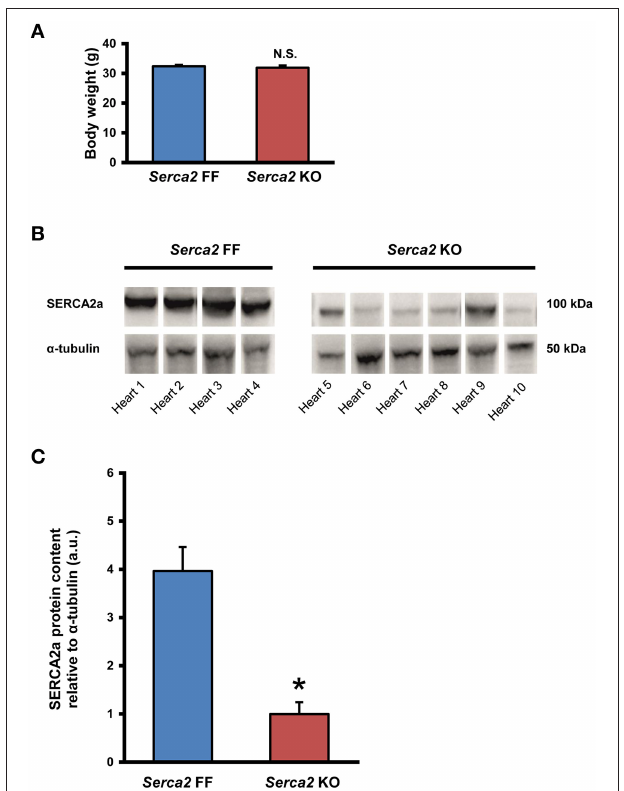
FIGURE 2 | SERCA2a expression in ventricular myocardium. (A) Body weight of Serca2 FF and Serca2 KO mice. (B) Western blots of SERCA2a protein and α -tubulin expression in ventricular myocardium of Serca2 FF (left; n = 4) and Serca2 KO (right; n = 6) hearts. (C) Mean values of SERCA2a band density normalized to α -tubulin in Serca2 FF and Serca2 KO samples. * P < 0.05 vs. Serca2